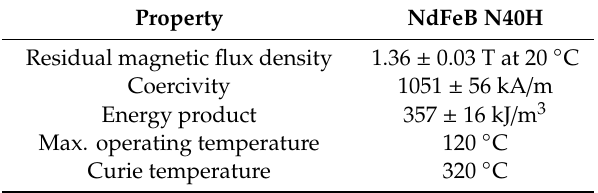
Table 4. Properties of N40H grade neodymium-iron-boron (NdFeB) permanent magnet material.